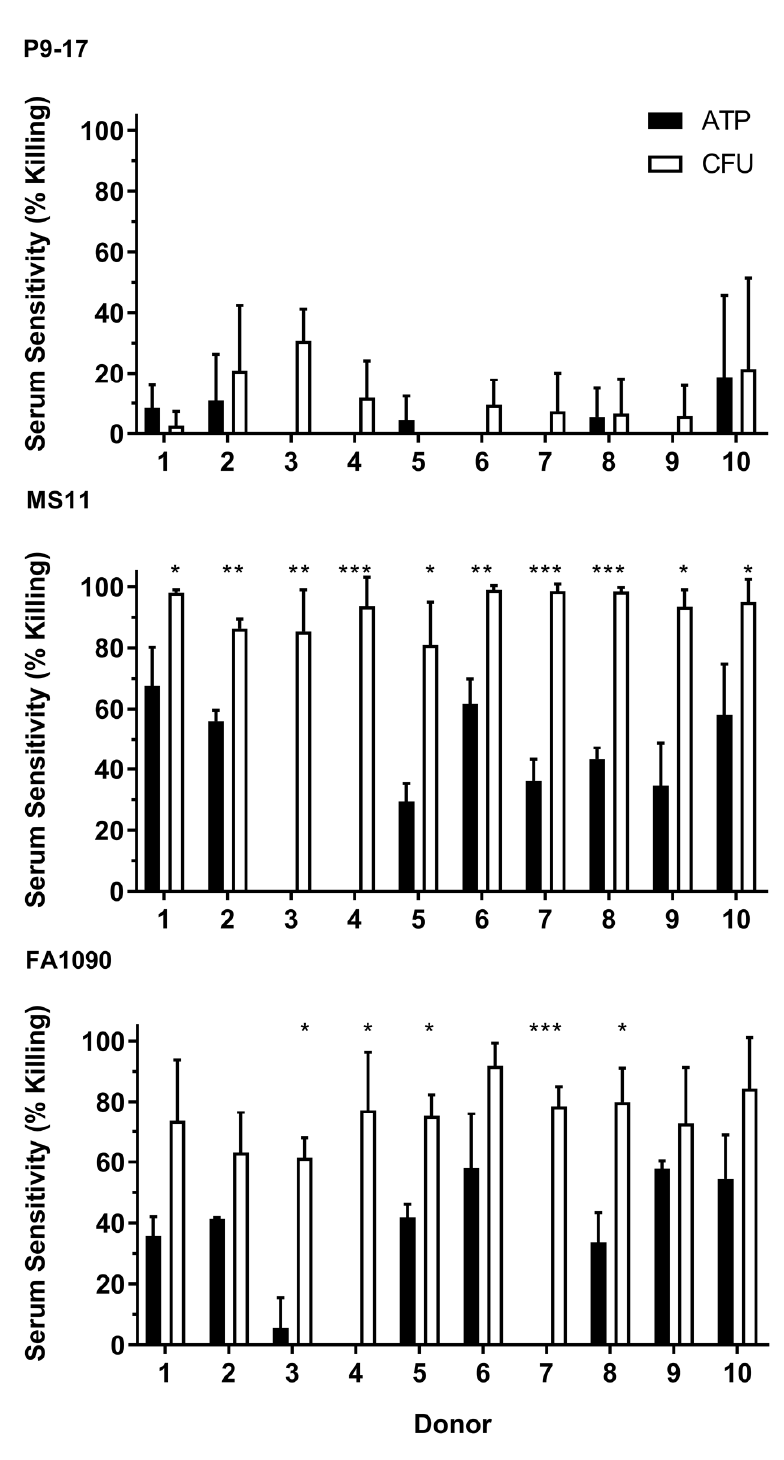
Figure 2. Detection of serum sensitivity of N. gonorrohoeae by enumeration of CFU versus ATP. N. gonorrhoeae strains P9-17, MS11 and FA1090 were tested for sensitivity to serum from 10 healthy human donors and samples taken to detect bacterial ATP or CFU. Data are combined means + SD from three independent experiments. Statistically significant differences in sensitivity between the two methods were determined using multiple t -tests with the Holm–Šidák method applied. * p < 0.05; ** p < 0.01; *** p < 0.001.